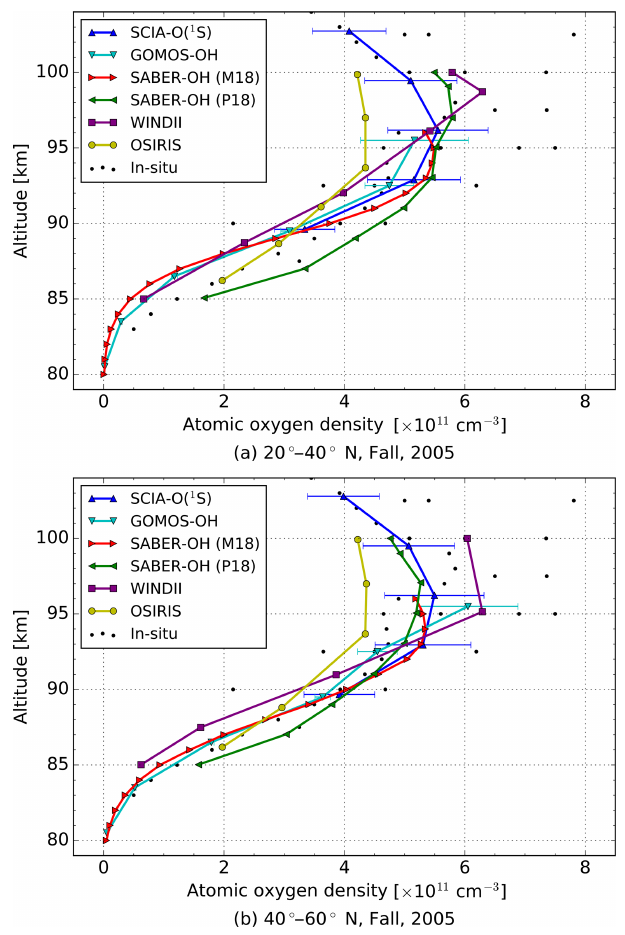
Figure 16. Comparison of atomic oxygen densities derived from various instruments and measurement techniques averaged for 20– 40 ◦ N (a) and 40–60 ◦ N (b) in autumn (September, October and November) 2005. SCIA-O ( 1 S ) is the atomic oxygen data derived from SCIAMACHY green-line emissions (Kaufmann et al., 2014; Zhu et al., 2015); SABER-OH refers to the atomic oxygen datasets derived by Mlynczak et al. (2018) (M18), and Panka et al. (2018) (P18) from SABER hydroxyl airglow emissions. The WINDII dataset is obtained from WINDII combined hydroxyl and green- line observations, 1993 (Russell and Lowe, 2003; Russell et al., 2005), while the OSIRIS dataset is derived from OSIRIS O 2 A- band measurements (Sheese et al., 2011). In situ data are obtained from rocket-borne experiments with mass spectrometers, conducted at different local times at 37–40 ◦ N, from 1972 to 1976 (Offermann and Grossmann, 1973; Trinks et al., 1978; Offermann et al.,